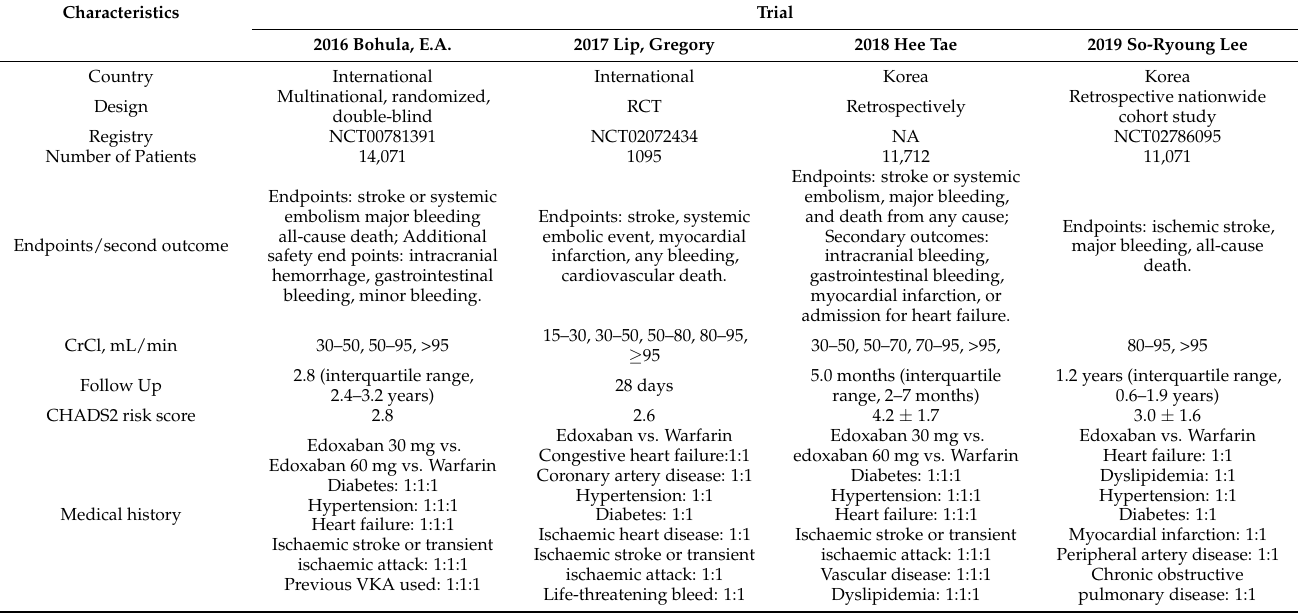
Table 1. Summary of the retrieved articles on edoxaban versus warfarin among AF patients in relation to